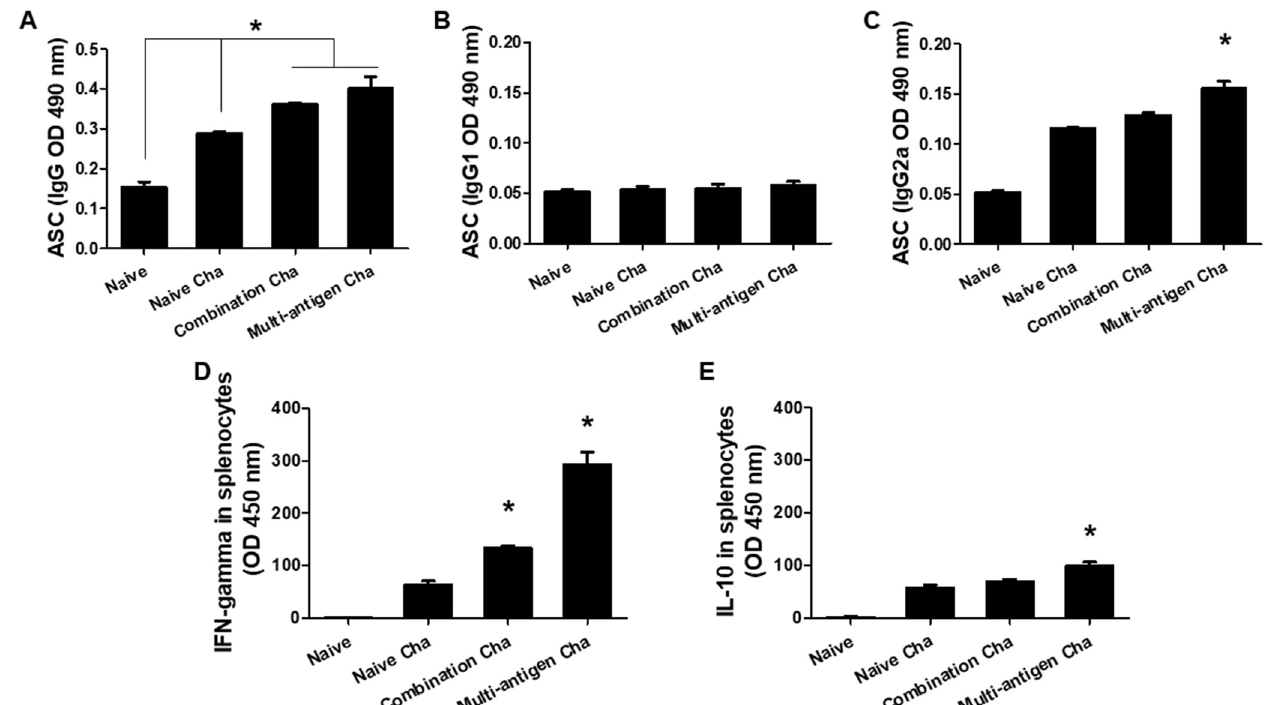
Fig 6. Antibody secreting cells (ASC) and cytokines responses. Spleen cells (10 6 cell/well) from mice were cultured and the level of IgG, IgG1 and IgG2a antibody secreting cells were determined (A, B and C). Higher level of T . gondii -specific IgG was found in multi-antigen or combination VLPs immunized mice (Multi-antigen Cha or Combination Cha) compared to Na ï ve mice (Na ï ve Cha) (A, � P < 0.01). The highest level IgG2a was found in Multi-antigen Cha mice compared to the other mice groups (C, � P < 0.01). To detect cytokines (IFN- γ and IL-10), splenocytes were cultured with T . gondii antigen (5 μ g/mL) (D and E). Significantly higher levels of IFN- γ and IL-10 were detected in Multi-antigen Cha compared to the other mice groups (D and E, � P < 0.01).